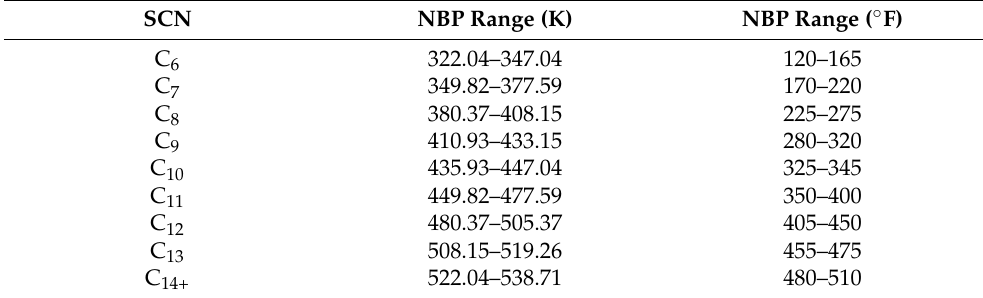
Table 9. Normal boiling point ranges used to classify single carbon number (SCN) pseudocomponents, as obtained from gas chromatography